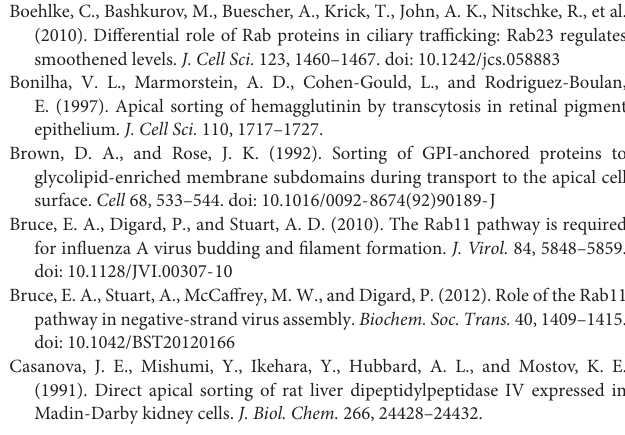
FIGURE S1 | Failure of influenza A virus infection in Rab17DN- and Rab23DN-expressing cells. MDCK cells were transiently transfected with a FLAG-Rab15DN, FLAG-Rab17DN, FLAG-Rab23DN expression, or empty plasmid and then infected with influenza A virus. At 9 hpi, cells were stained with anti-FLAG mAb (green) and anti-NP Ab (red) and cell nuclei (blue) were stained with DAPI. The green and red channel images were also shown in gray. Confocal images in the xy planes were shown. Scale bar, 10 µ m. FIGURE S2 | Failure of Rab23 localization to PM by coexpression with Rab17DN. Parental MDCK cells were transfected with FLAG-Rab17DN and FLAG-Rab23DN expression plasmids. After 12 hpt, cells were transfected with AcGFP-Rab17 and AcGFP-Rab23 expression plasmids and additionally FLAG-Rab17DN and FLAG-Rab23DN expression plasmids. The cells were stained with anti-FLAG mAb (red), and cell nuclei (blue) were stained with DAPI. The green and red channel images were also shown in gray. All images were taken at the same magnification. Scale bar, 10 µ m. MOVIE S1 | Cotrafficking of NA-mSB and HA-EGFP, and NA-mSB transport by AcGFP-Rab17- and AcGFP-Rab23-positive vesicles. Parental MDCK cells were transiently cotransfected with HA-EGFP and NA-mSB expression plasmids. MDCK cells stably expressing AcGFP-Rab11, Rab15, Rab17, and Rab23 were transfected with an NA-mSB expression plasmid. For live-cell imaging, dual-color images with excitation at 488 and 568 nm were sequentially acquired at 1-s intervals for 100 s and were processed by using ImageJ software. MOVIE S2 | Impairment of AcGFP-Rab17- and AcGFP-Rab23-associated NA-mSB transport by cholesterol depletion. MDCK cells stably expressing AcGFP-Rab17 and AcGFP-Rab23 were pretreated with 16 µ M lovastatin and then transfected with an NA-mSB expression plasmid. The cells were treated with 16 µ M lovastatin plus 10 mM M β CD for 1 h before live-cell imaging. Dual color images were sequentially acquired at 1-s intervals for 100 s and were processed by using ImageJ software. For comparison, dual color live-cell images of HA-EGFP and NA-mSB in lovastatin/M β CD-untreated cells were